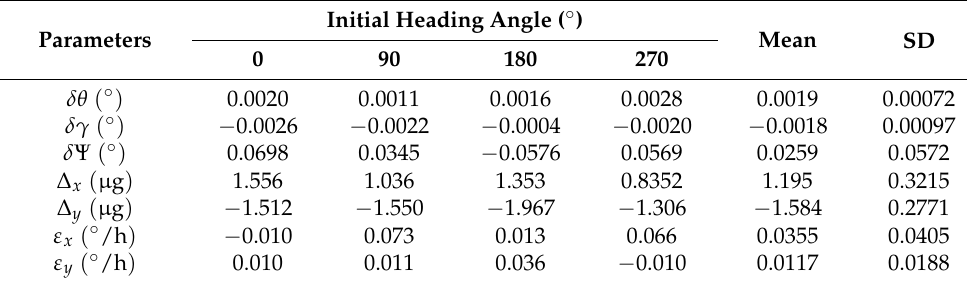
Figure 5. Estimation values of IMU constant error (uniform linear motion). Table 3. Statistical results of uniform linear motion.